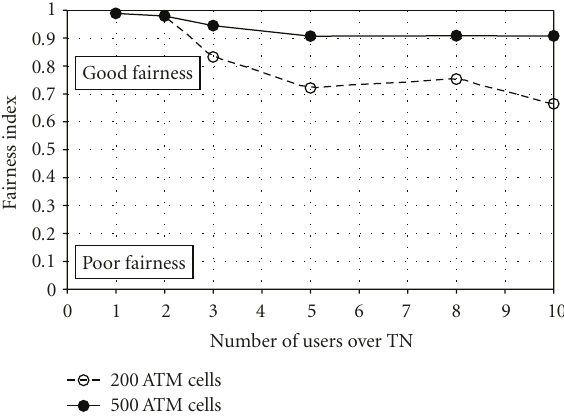
Figure 8: Average DF delay on TN for di ff erent TN capacities.